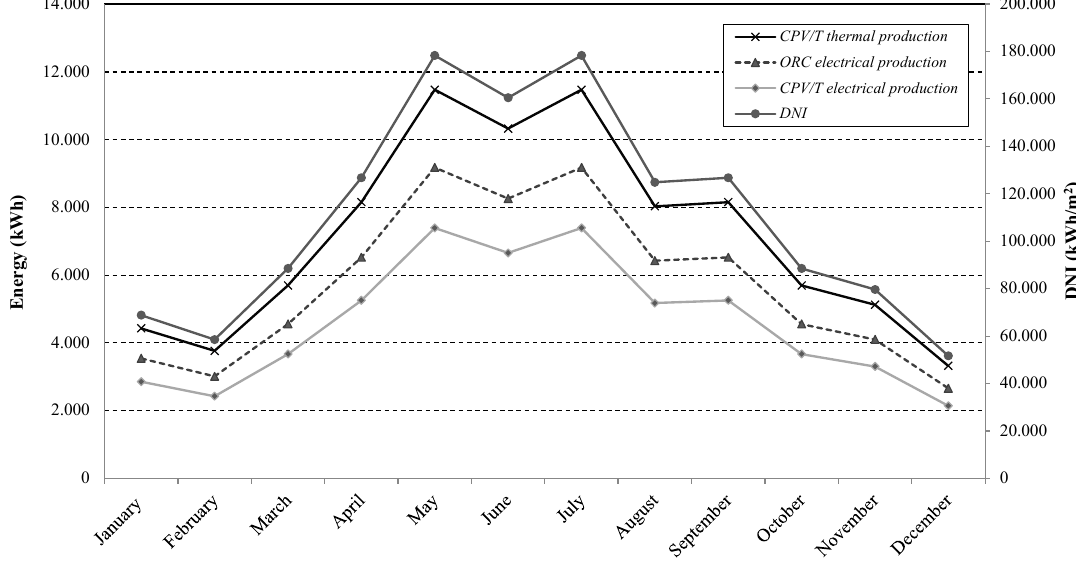
Figure 9. Monthly energy production of the combined CPV/T-ORC system.